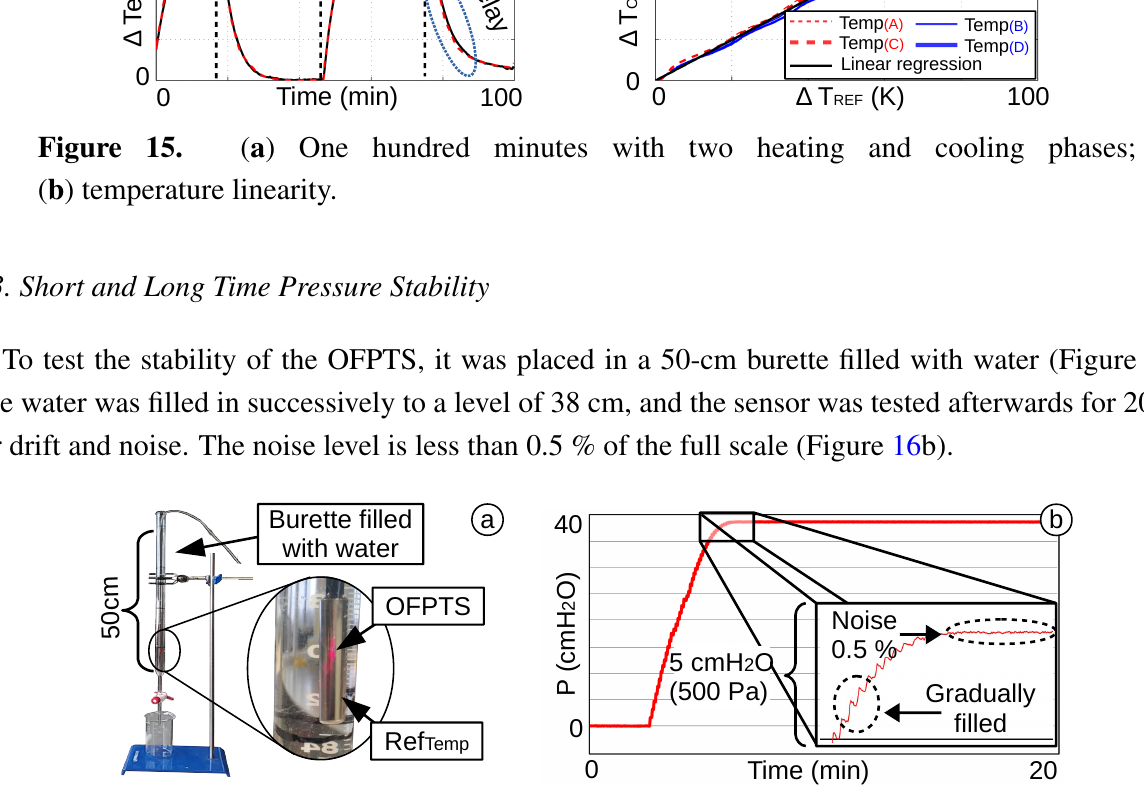
Figure 16. ( a ) A 50-cm burette filled with water; ( b ) 20-min stability test of an